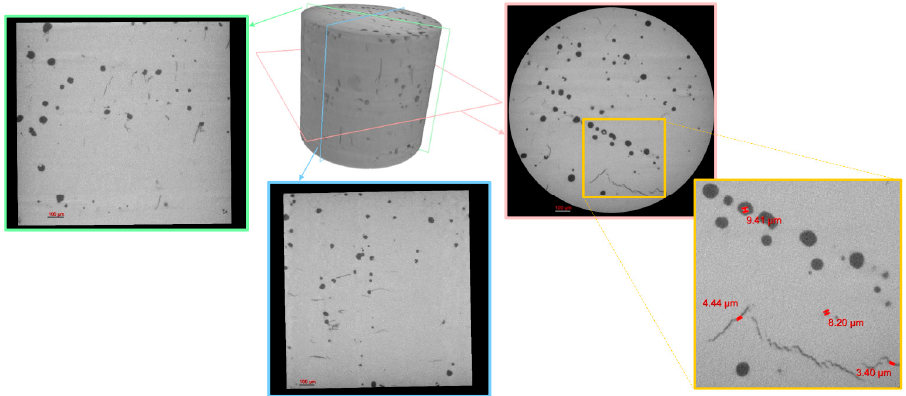
Figure 6. Overview of the scanned sample using ZEISS Xradia 620 Versa.